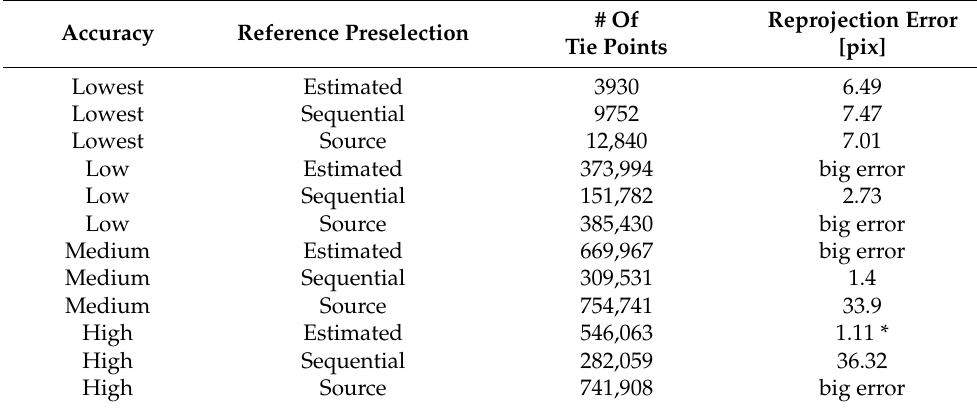
Table 2. DJI Matrice 300 RTK wide photos alignment results.